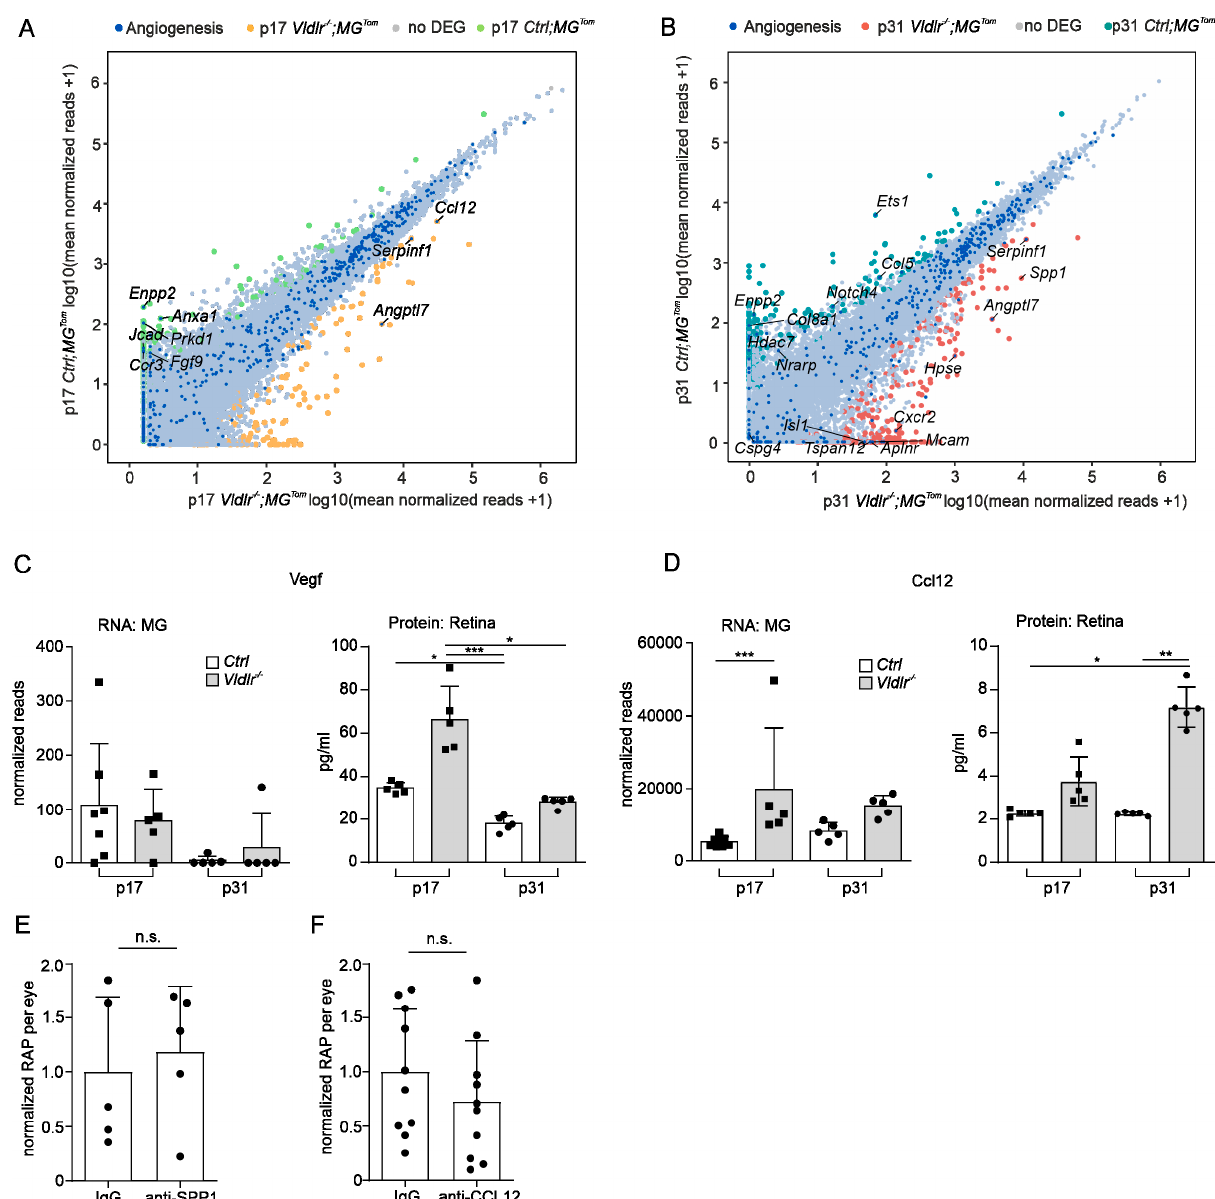
Figure 4. Angiogenic potential of retinal microglia during RAP . ( A , B ) Readplot using the log2 transformation of normalized reads visualizing differentially expressed genes between microglia from Ctrl ; MG Tom mice (y-axis) and Vldlr − / − ;MG Tom mice (x-axis) on postnatal day (p)17 ( A ) and p31 ( B ). Genes associated with angiogenesis are labeled blue. ( C , D ) Comparison of RNA Seq results of isolated microglia and protein analysis of retinal tissue lysates from Vldlr − / − ;MG Tom and Ctrl ; MG Tom mice at postnatal day (p)17 and p31 for Vegf ( C ) and Ccl12 ( D ). mRNA: n = 5–7 samples per group, protein n = 5 samples per group. ( E , F ) Intravitreal injection of anti-SPP1 (( E ), n = 5) or anti-CCL12 (( F ), n = 10) in comparison to an IgG injection (*; p < 0,05; **, p < 0.01; ***, p < 0.001).